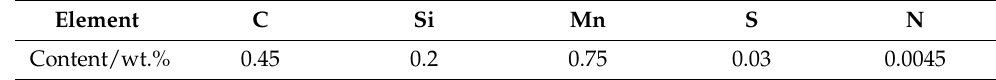
Table 1. Chemical composition of 45 steel.